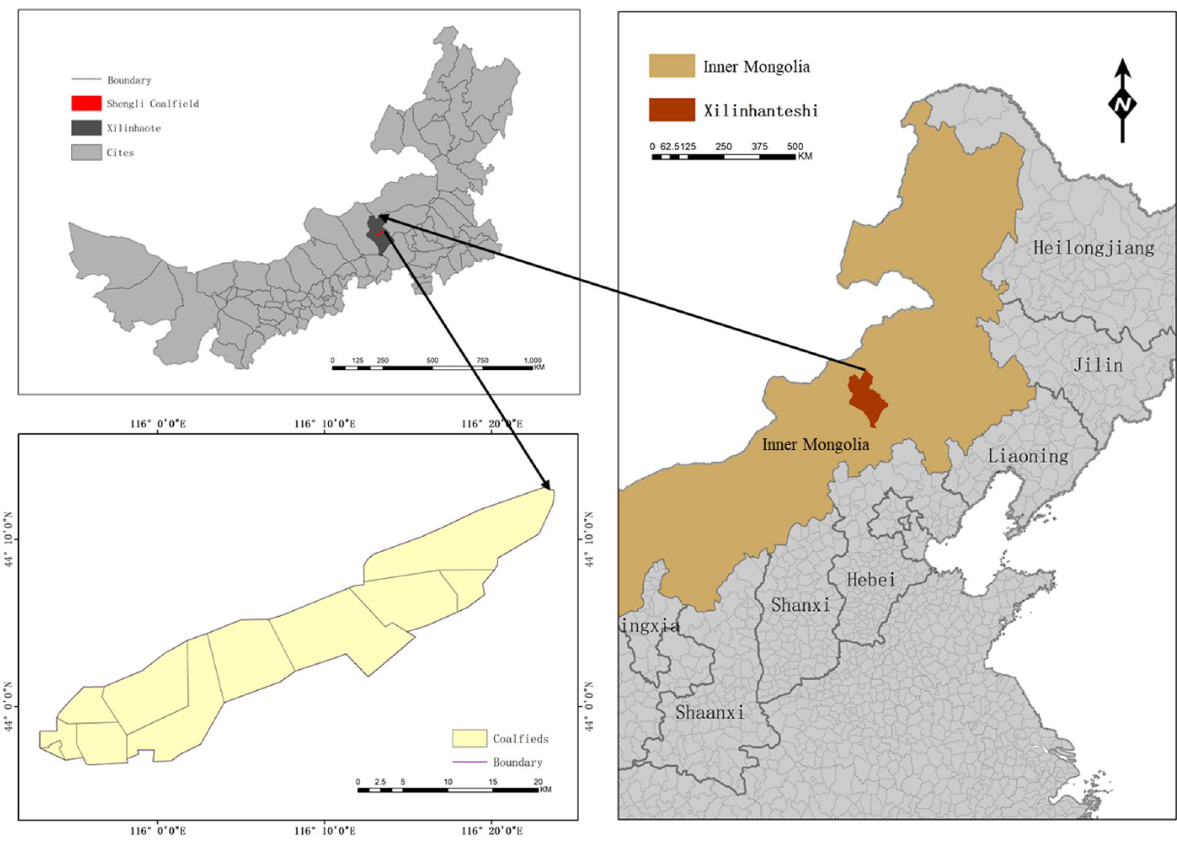
Fig. 1 Location of Shengli